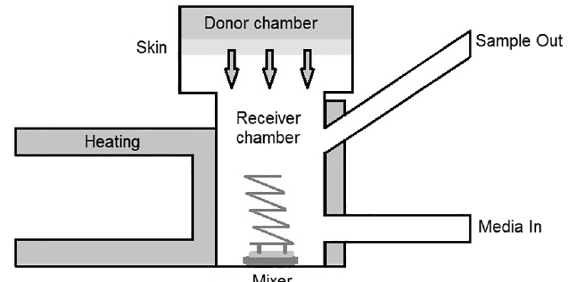
FIGURE 2 - Vertical diffusion cell (Reproduced with permission from Wiley-Scrivener from Ruela, Pereira,